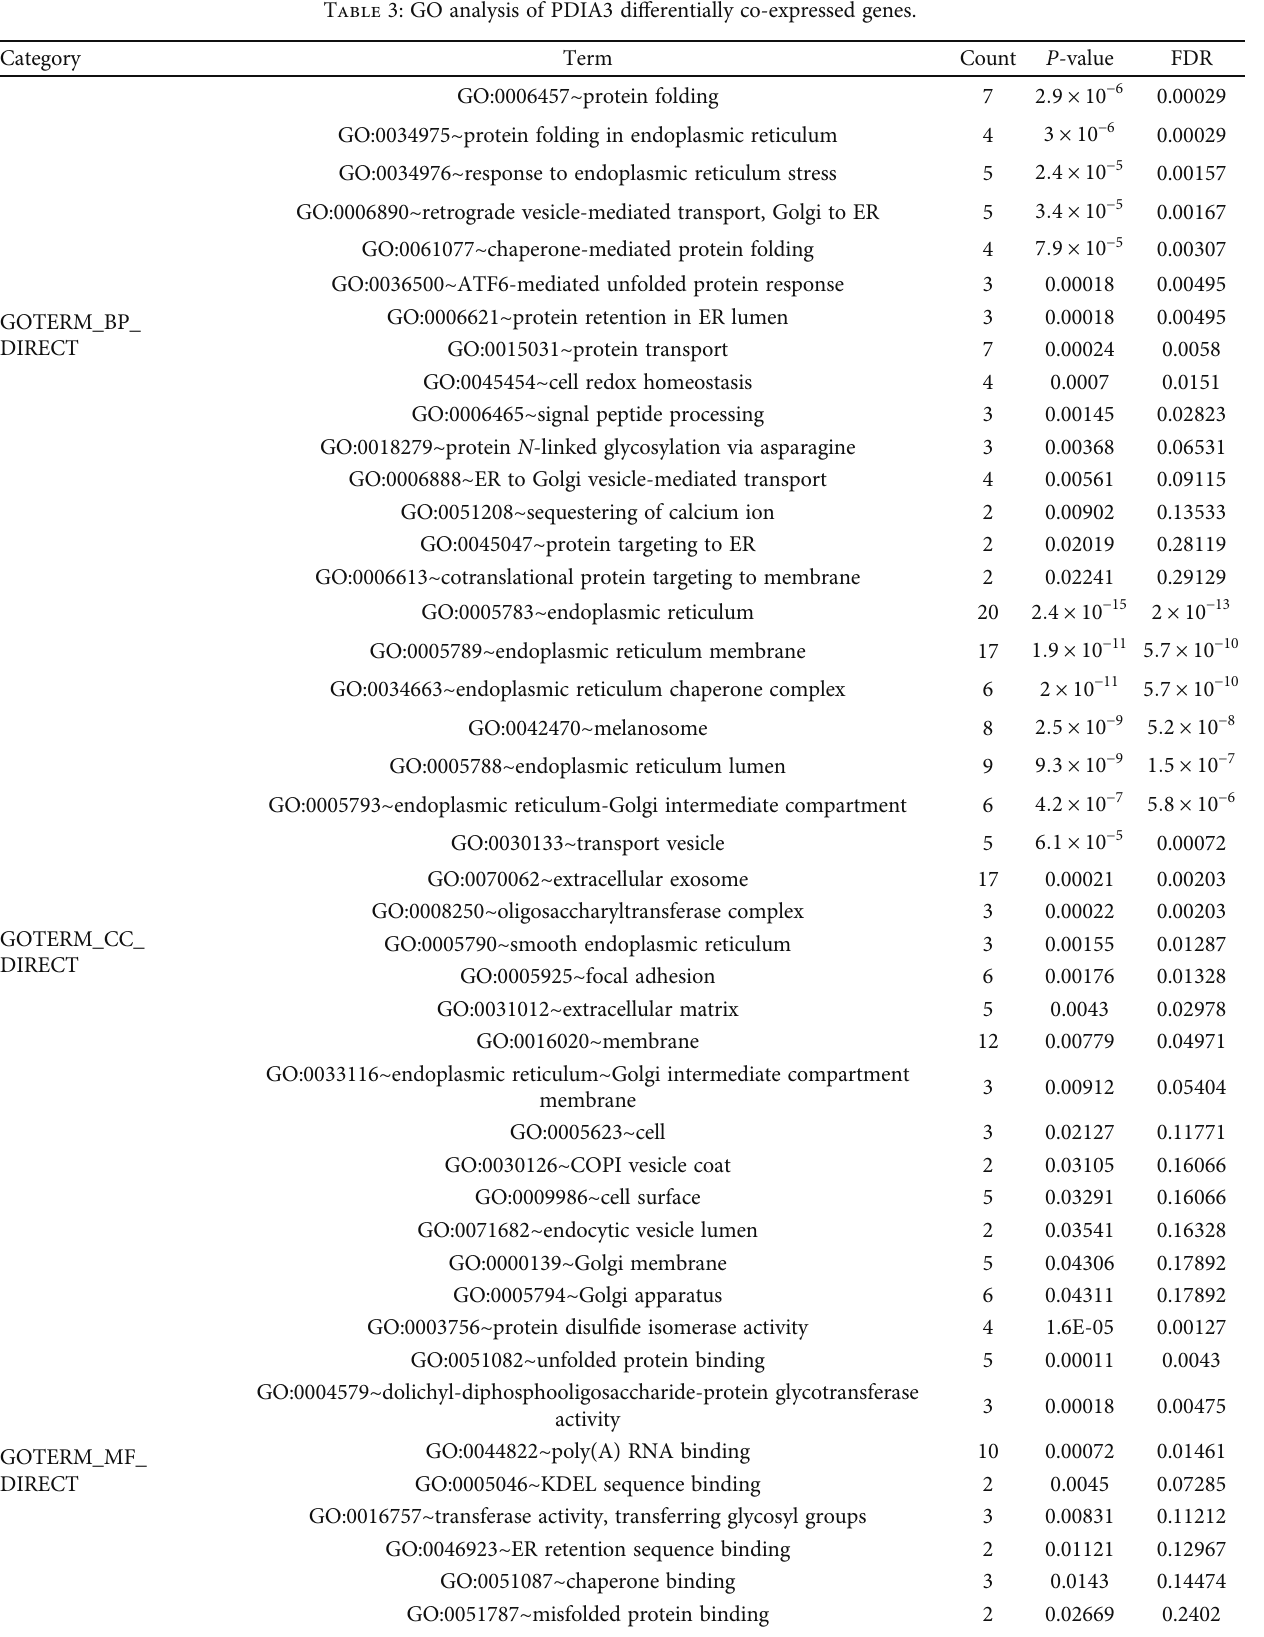
Table 3: GO analysis of PDIA3 di ff erentially co-expressed